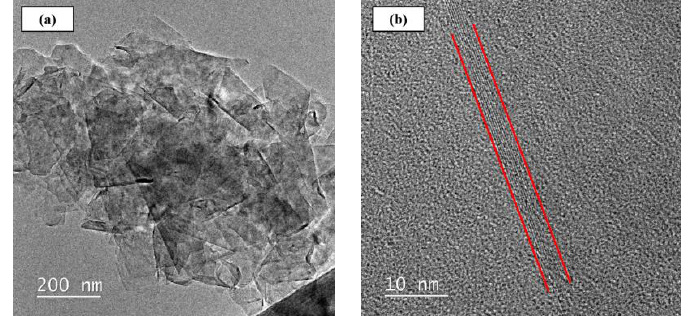
Figure 2. TEM images of as-received GNPs: ( a ) ×200, ( b ) ×10 k.